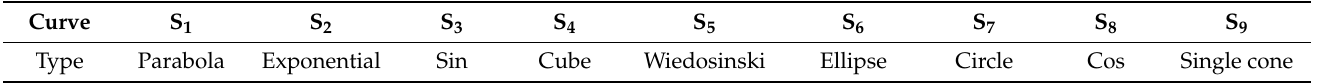
Table 2. Shape functions of section curves for contraction sections.